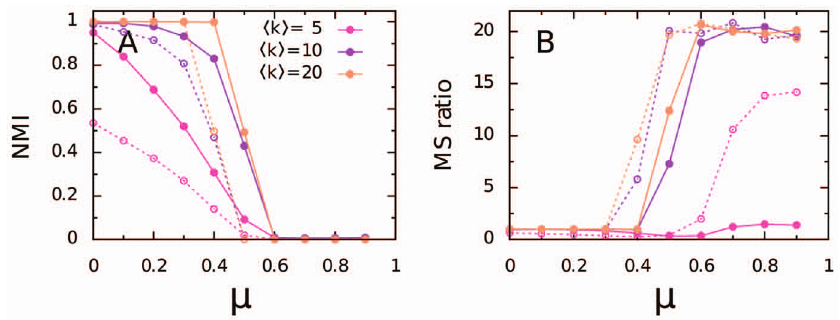
Figure 4. The success of triangle completion depends on the module mixing. Similarity between the community structure of the original network and the perturbed networks for three different average degrees S k T as a function of the module mixing parameter m . In panel A the similarity is quantified in terms of the normalized mutual information (NMI) and in panel B the similarity is quantified in terms of the module size ratio. Filled lines and circles correspond to triangle completion and dashed lines and open circles correspond to random link addition. No links were removed prior link addition and the number of links were doubled in all networks by link addition. Each point corresponds to an average over 100 networks.